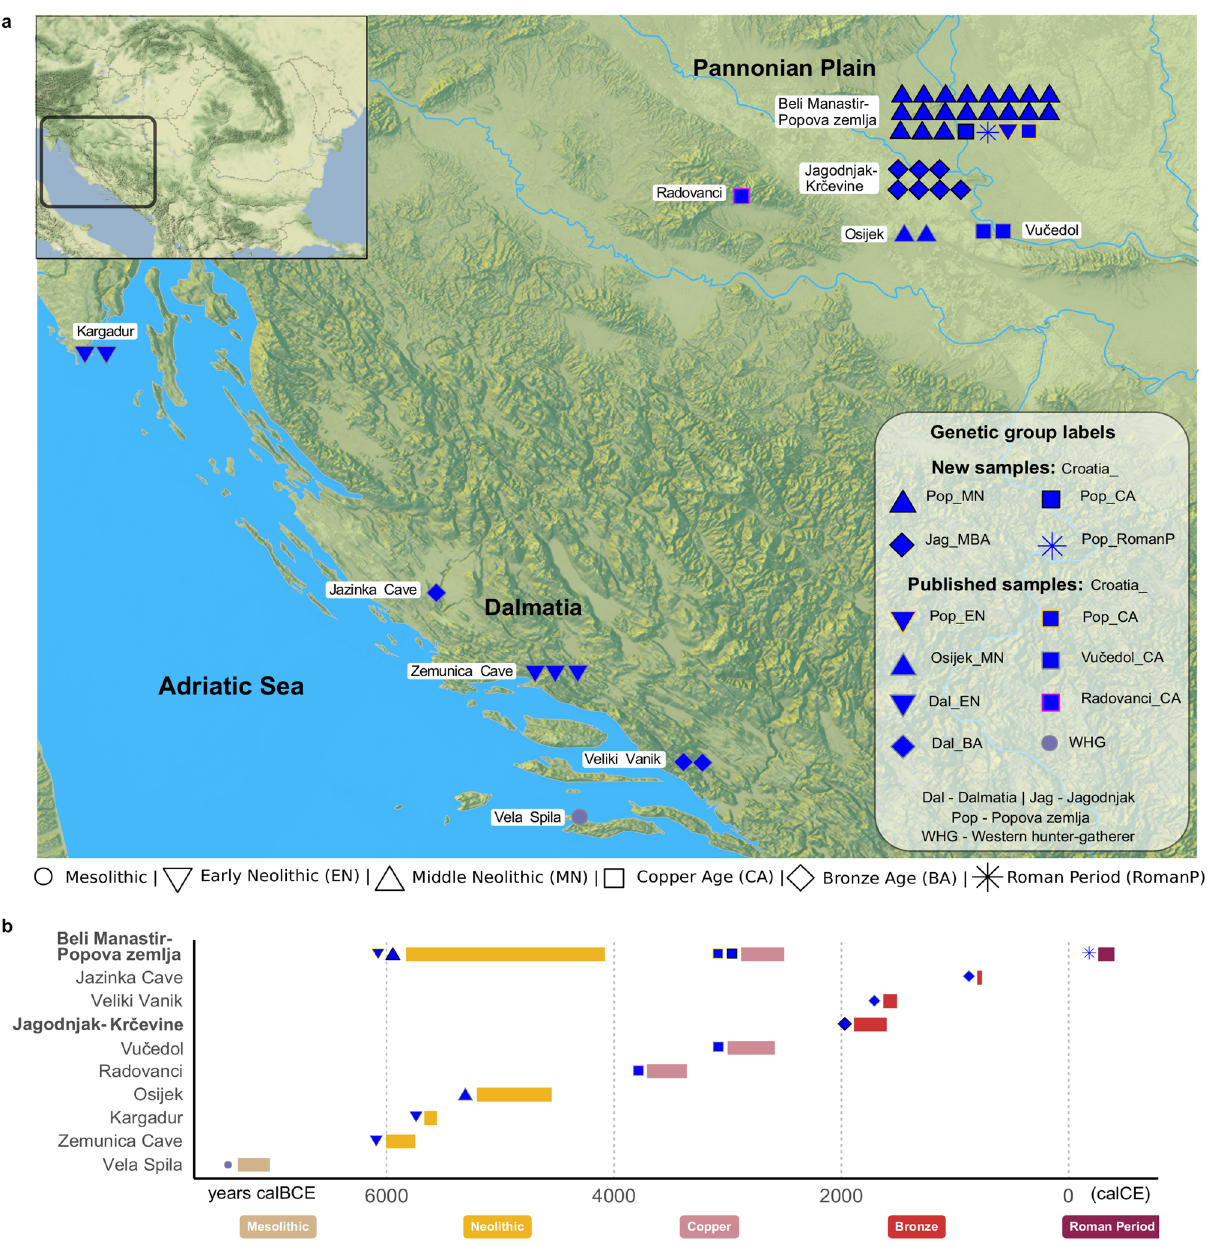
Figure 1. Location and dates of archaeological sites in Croatia. ( a ) Map showing location of archaeological sites for published and newly-reported samples (Table 1, Supplementary Tables S1 and S2). Each point represents a sample, with newly-reported samples outlined in black. Previously-published samples from Popova zemlja are outlined in orange. Genetic group labels include a shortened form of site or region: Pop Popova zemlja, Dal Dalmatia, Jag Jagodnjak. WHG indicates the group label Western Hunter-Gatherer. Shapes correspond to samples of different time periods: EN Early Neolithic, MN Middle Neolithic, BA Bronze Age, CA Copper Age, MBA Middle Bronze Age, RomanP Roman Period. See Methods for further time period labels used for other reference populations. Map made with Mapzen terrain tiles obtained from AWS Public Dataset (https:// regis try. opend ata. aws/ terra in- tiles/). European terrain data produced using Copernicus data and information funded by the European Union - EU-DEM layers. Ocean, river and lake data from Natural Earth. Free vector and raster map data @ naturalearthdata.com.Top left inset map of the region, made with map tiles by Stamen Design, under CC BY 3.0. Data by OpenStreetMap, under ODbL. ( b ) Combined radiocarbon and contextual date ranges for samples from present-day Croatia (Table 1, Supplementary Tables S1 and S2, Methods). Site names for newly-reported samples are highlighted in bold. All plots were produced using R 3.5.2 102